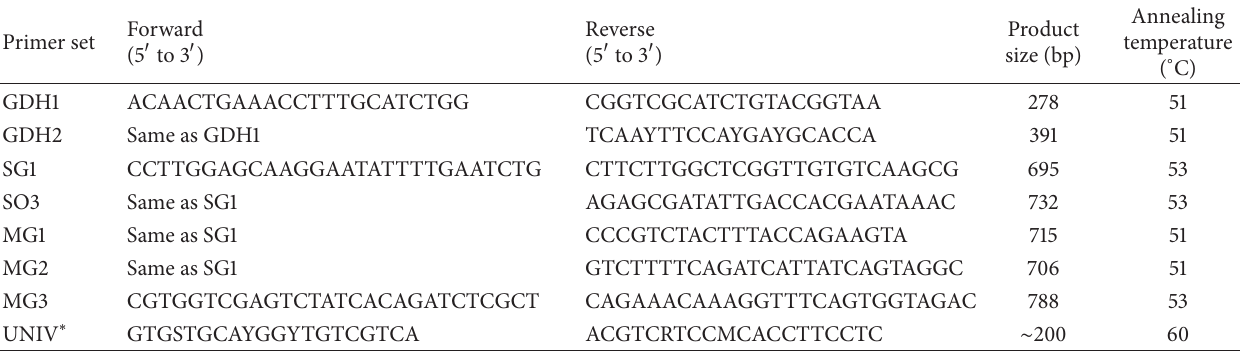
Table 1: Primer sequences and annealing